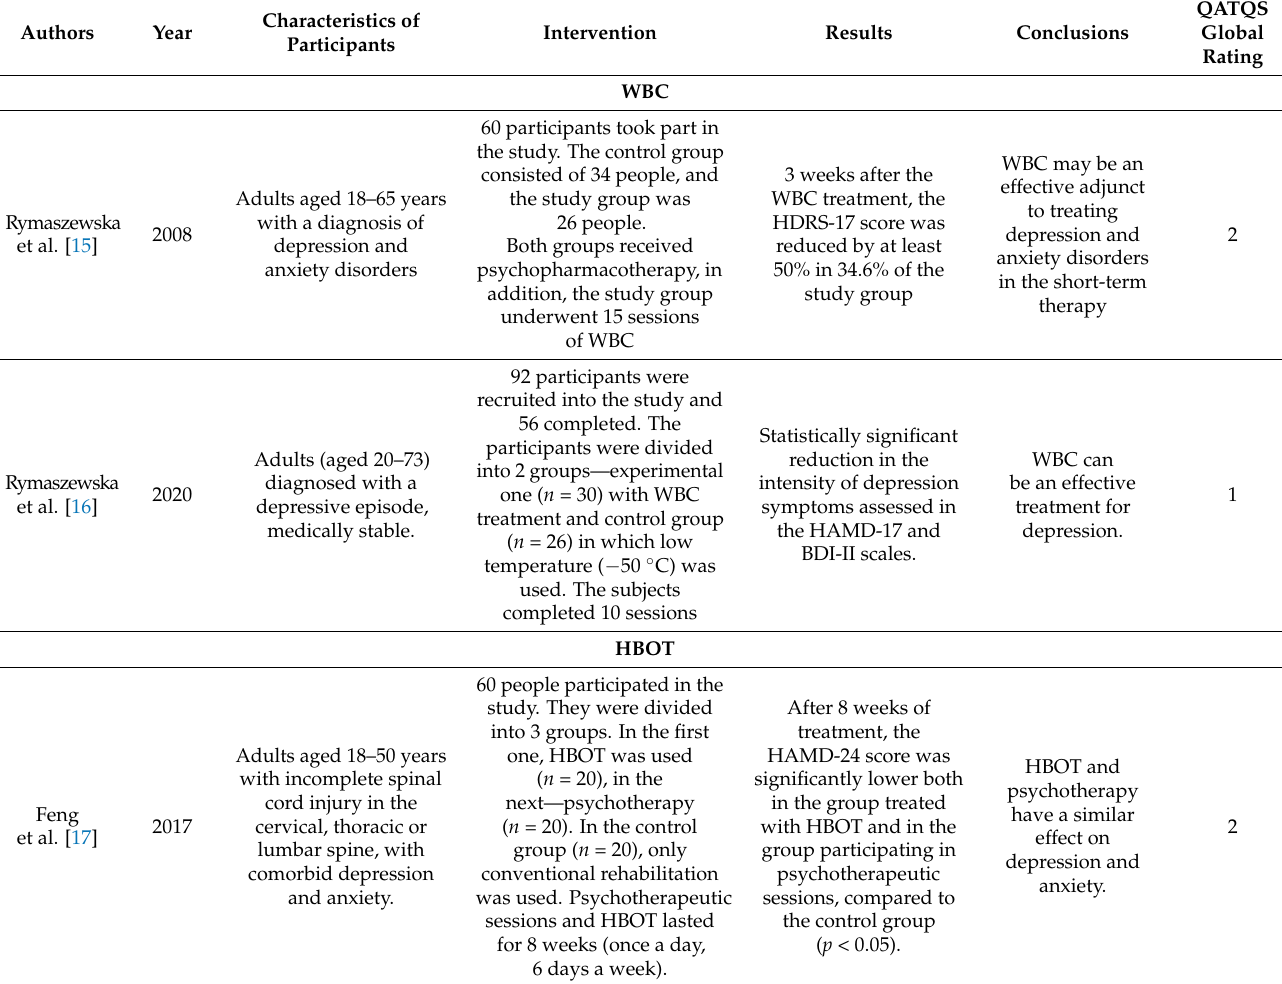
Table 1. Summary description of the publications selected for the analysis, regarding influence of WBC or HBOT on depressive episode treatment. The risk of bias and study quality assessed with the Effective Public Health Practice Project’s Quality Assessment Tool for Quantitative Studies (QATQS) was presented as the global rating for each publication (1—strong, 2—moderate,